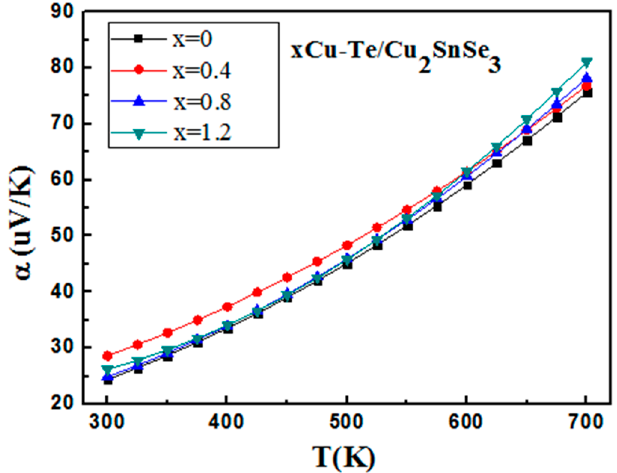
Figure 7. Temperature dependence of Seebeck’s coefficient ( α ) of Cu–Te/Cu 2 SnSe 3 composites.